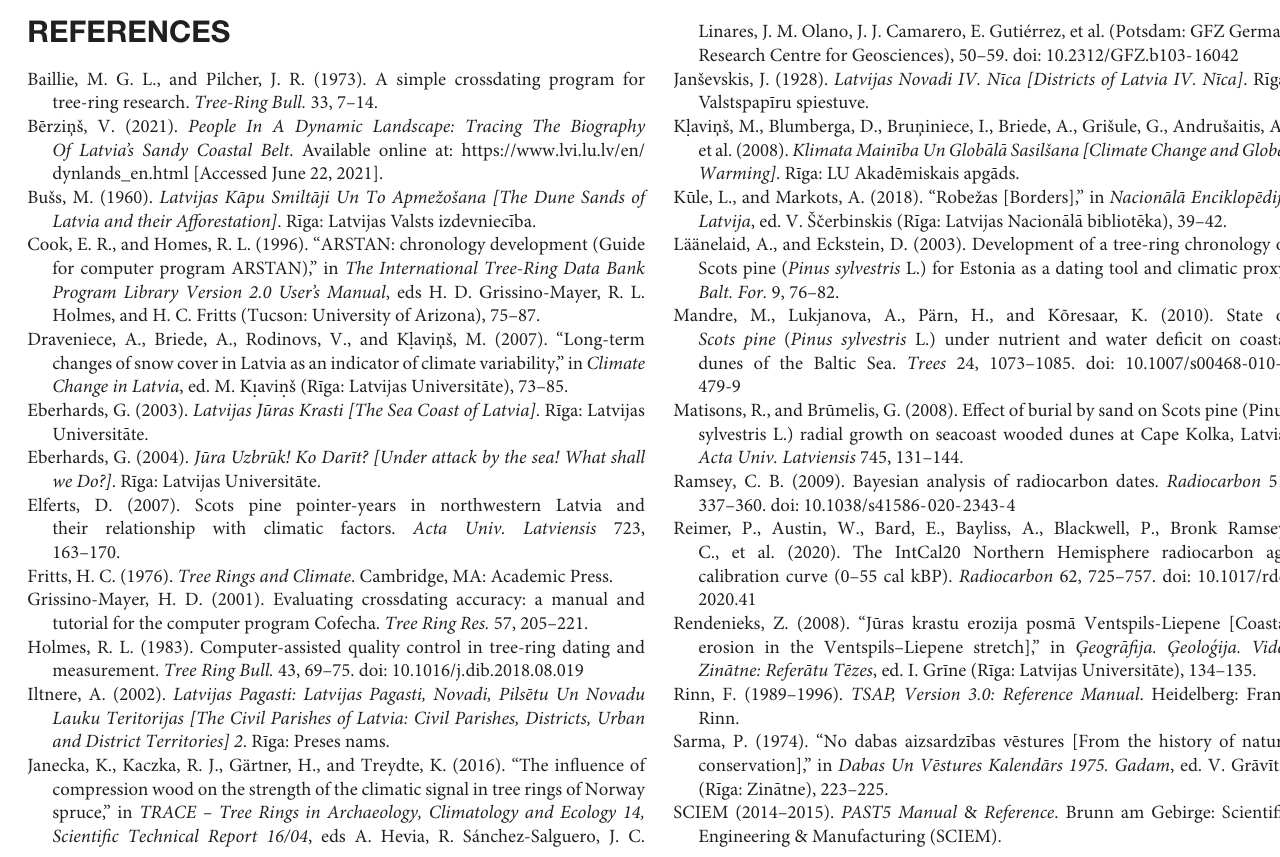
Supplementary Figure 1 | TRW series and absolute tree-ring chronologies for living pines utilized in the study. (A) TRW series for living and recently dead pines. (B) TRW series for pine timbers from jetty structure. (C) TRW series for pine trunk remnants. (D) Absolute tree-ring chronologies for living pines. a Undated pine TRW